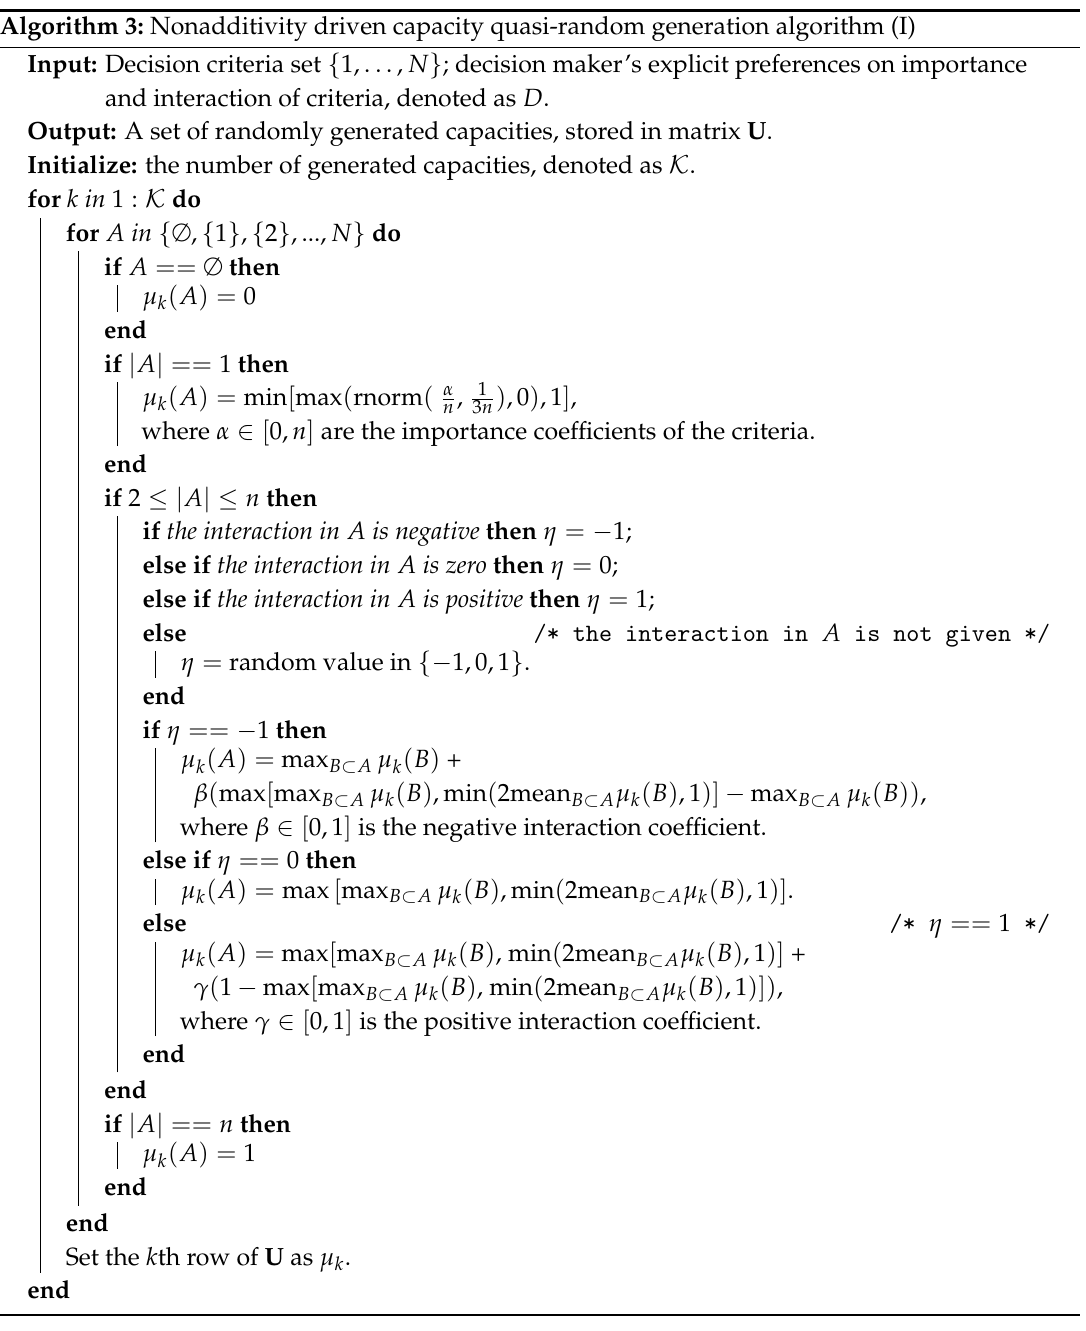
Algorithm 3: Nonadditivity driven capacity quasi-random generation algorithm